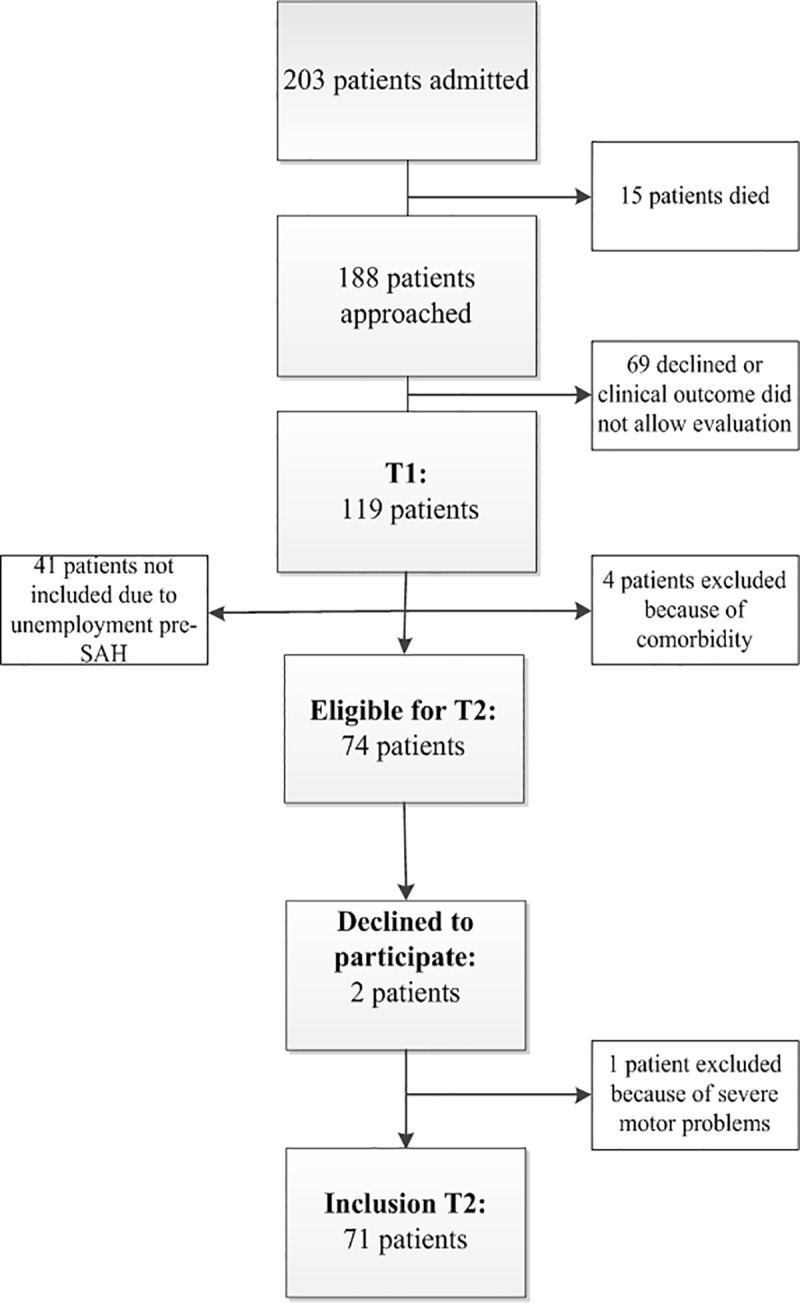
Flow chart of included and excluded patients.